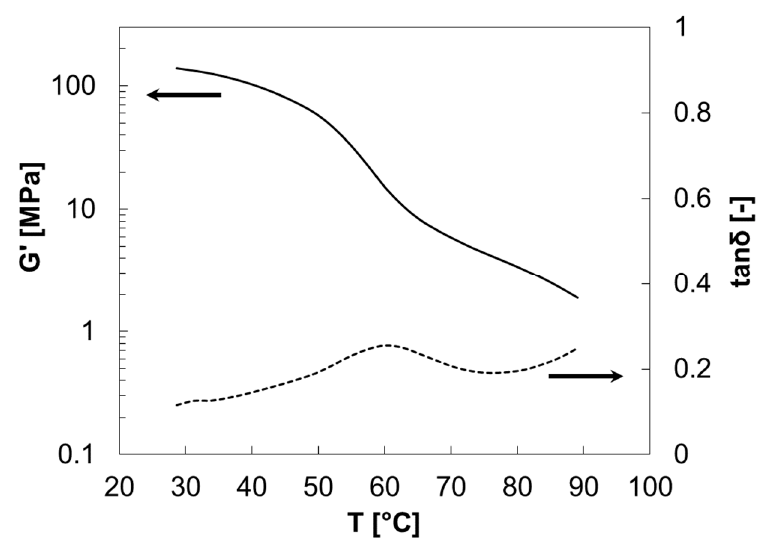
Figure 5. Storage shear modulus, G’ (–) and dissipation factor, tan δ (--) measured by DMA after one day of aging.